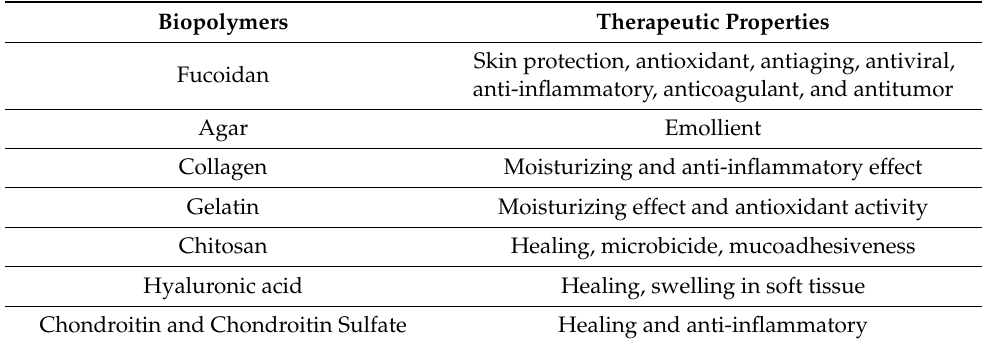
Table 1. Biopolymers used in film production and their therapeutic